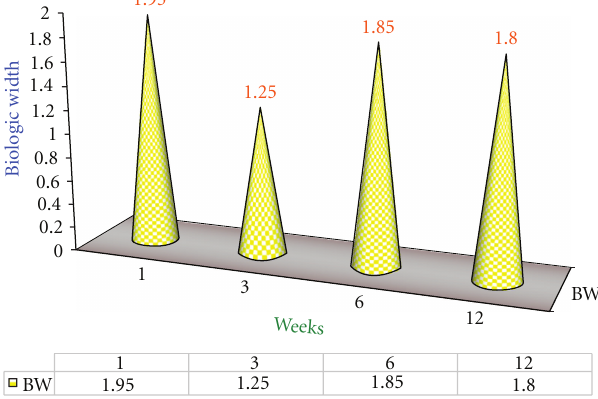
Figure 5: Deviation graph of position of gingival margin from reference stent (PGMRS) (B2 Group) at various intervals of weeks.